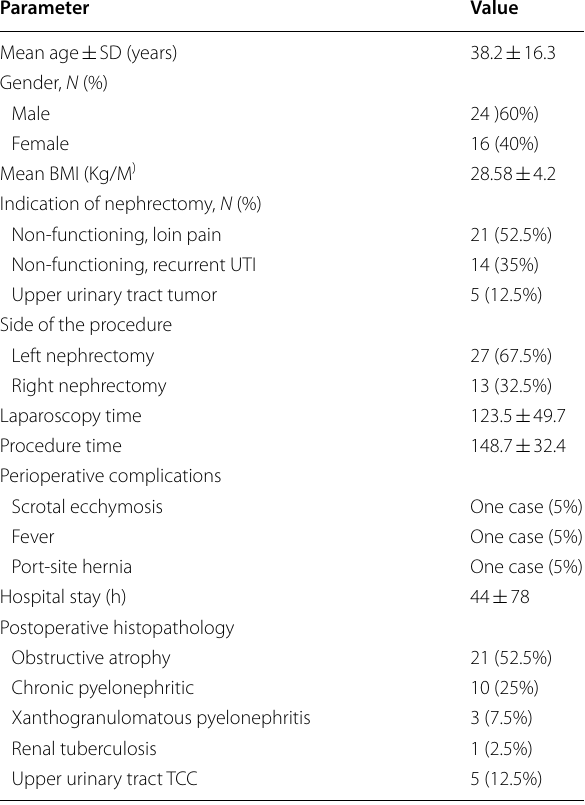
Table 1 Patients’ demographics, intraoperative and postoperative